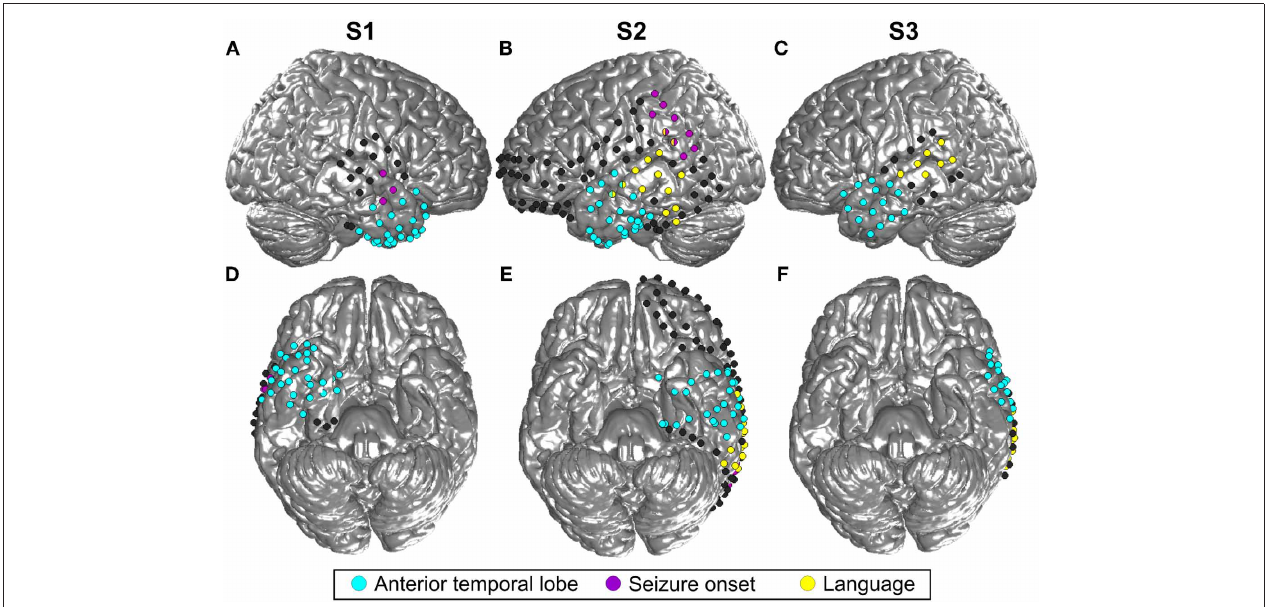
FIGURE 2 | Location of all implanted grid and stripe electrodes in the three included subjects (S1–3). (A) is the lateral view of the right hemisphere of S1 and (B) and (C) show the left hemisphere of S2 and S3, respectively. (D,E,F) Display the corresponding bottom sides of the brain. Blue color indicates all contacts located in the ATL, contacts in yellow